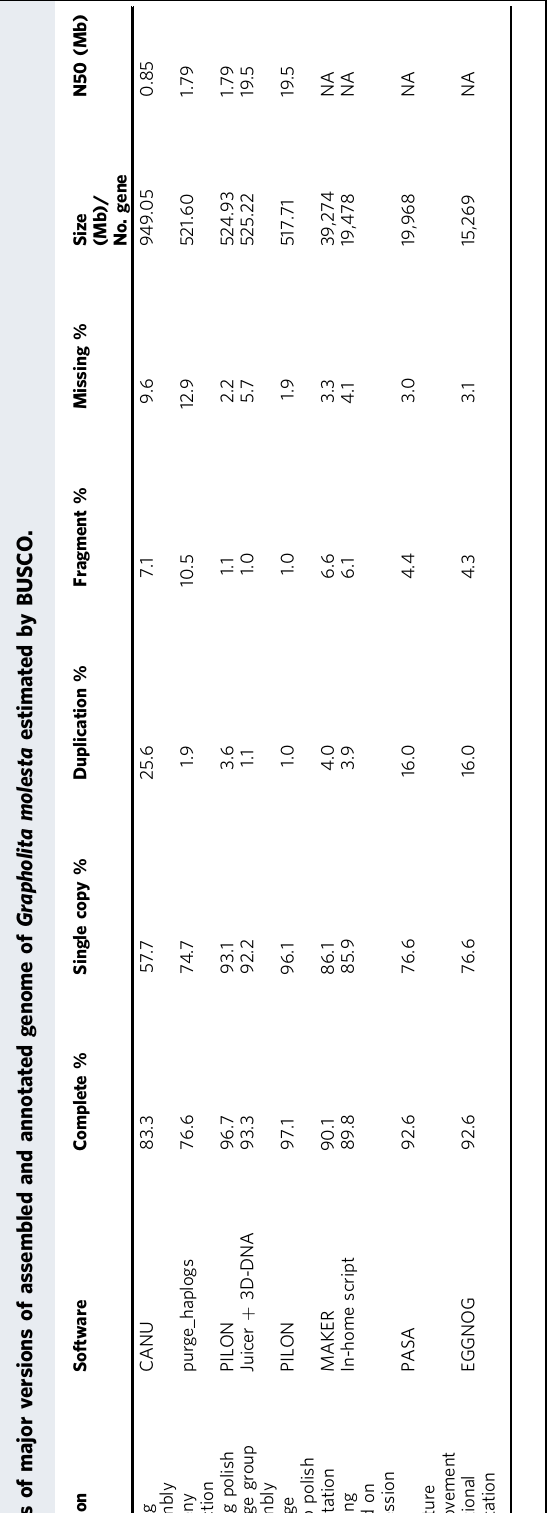
rated into three clusters corresponding to the three